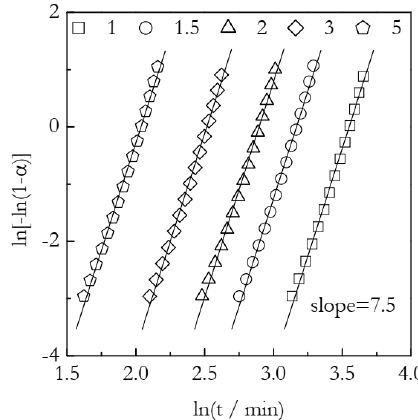
Figure 2. Avrami plots for the simulated nonisothermal data ( n = 3). Numbers by the symbols are heating rates in K min − 1 .